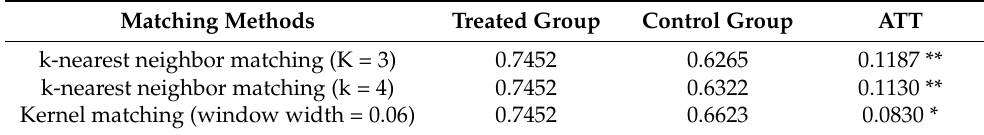
Table 4. Treatment effect of Internet use on organic fertilizer application. Matching Methods Treated Group Control Group ATT k-nearest neighbor matching (K = 3) k-nearest neighbor matching (k = 4) Kernel matching (window width =